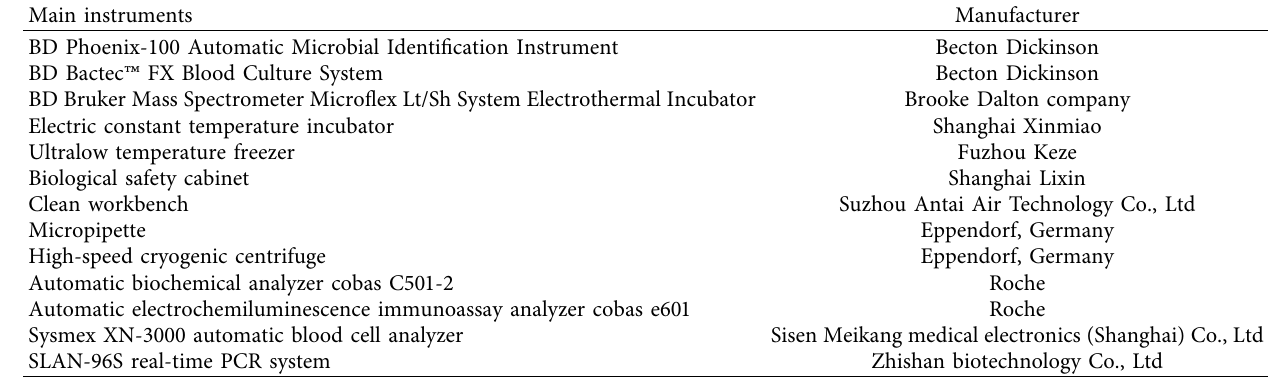
Table 3: Main instruments and manufacturers used in test process.